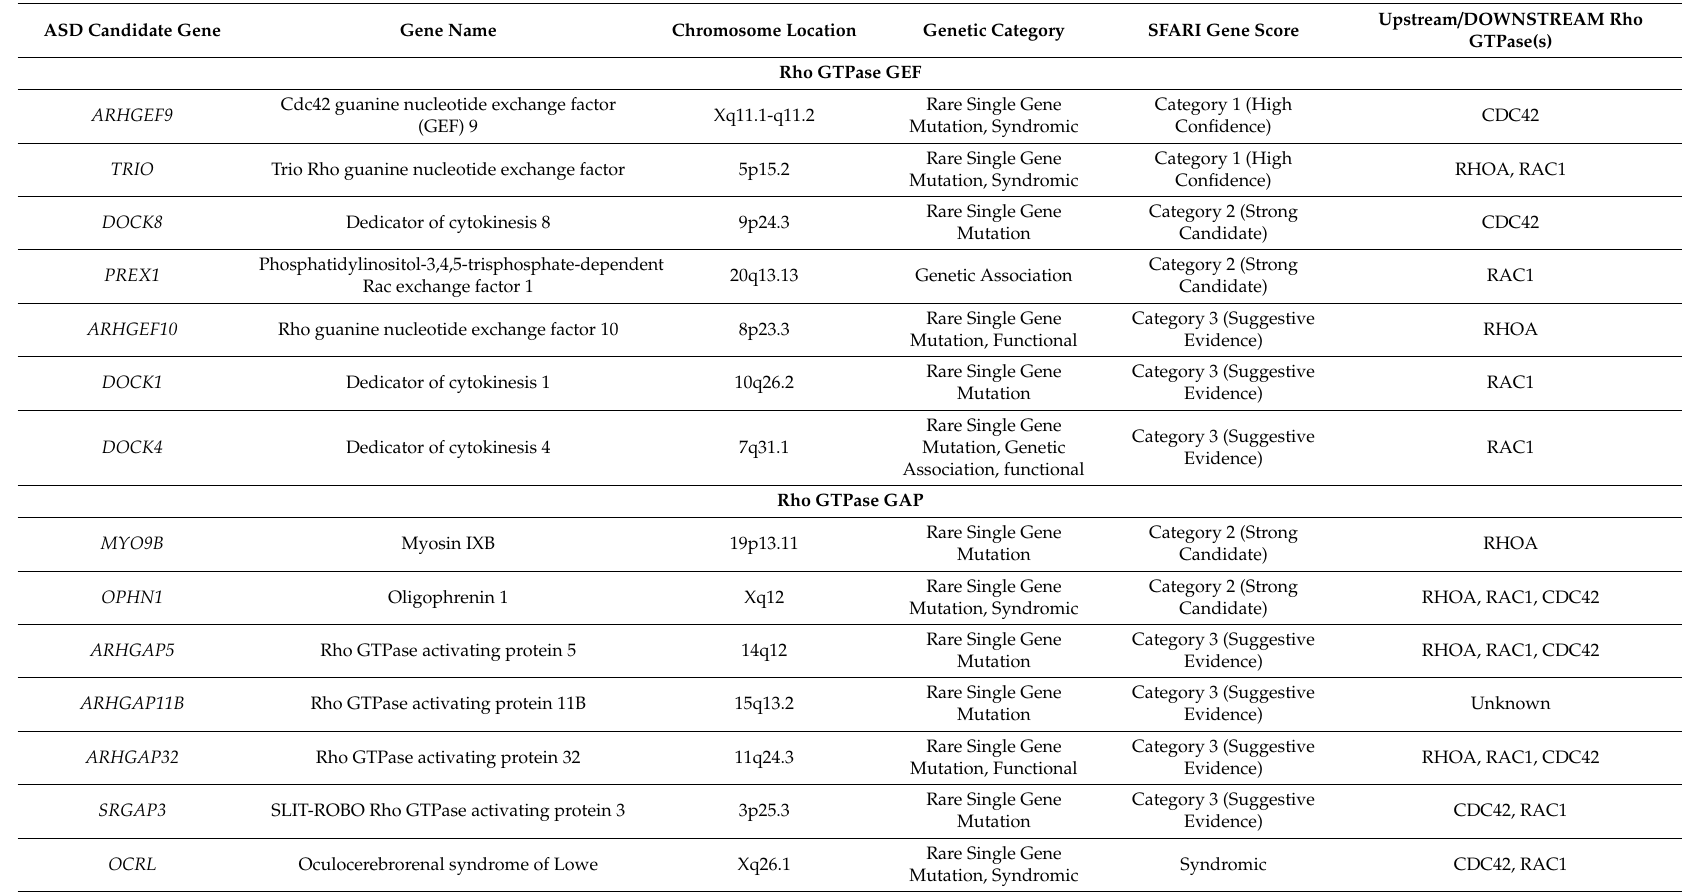
Table 1. Rho family GTPases involved in